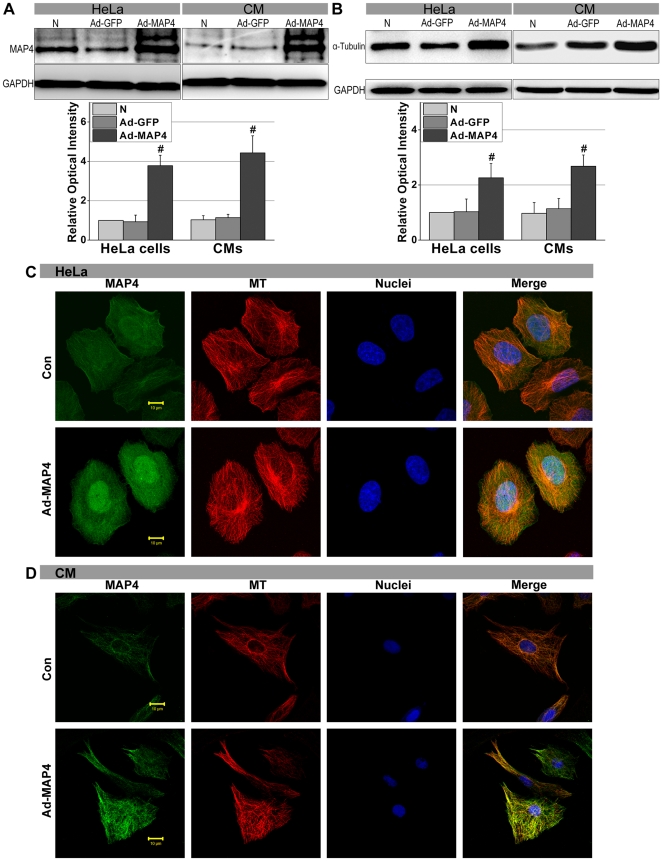
MAP4 overexpression increases the amount of α-tubulin and MT networks.
A and B, Western blots showed that the expression of MAP4 and gross quantity of α-tubulin in HeLa cells and CMs after Ad-MAP4 was elevated after transfection. Graphs represent the mean±SEM of the relative optical density signals for three separate experiments (n = 3). N - non-transfected cells. # P<0.01 vs. N and Ad-GFP, Student's t test analysis. Cytosol GAPDH was chosen as the internal control. C and D, Immunofluorescent confocal micrographs of HeLa cells and CMs. Micrographs show that cells contain a larger amount of MAP4 (FITC-green) and more luxuriant MT network structure (TRITC-red) after Ad-MAP4 transfection compared with Con (Non-transfected cells). Scale bar, 10 µm.